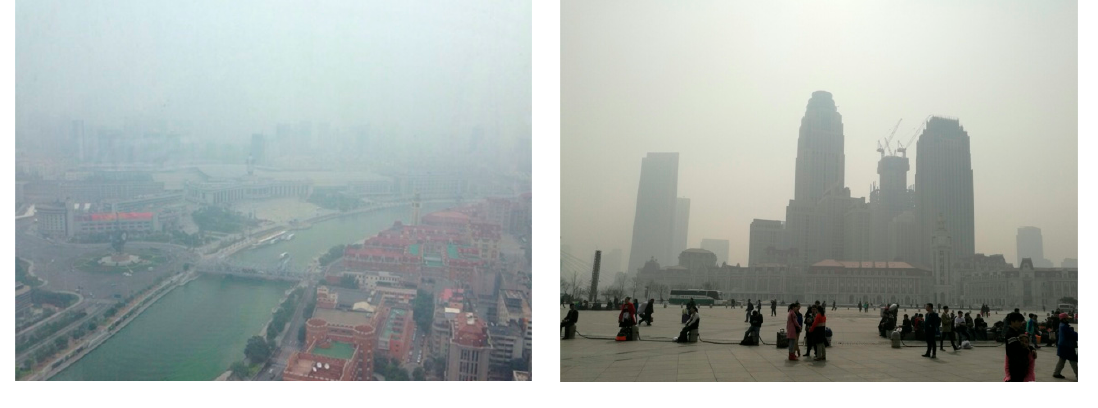
Figure 2. Tianjin under the haze in recent years (all the photos are taken from the posted Sina microblog messages [48]).